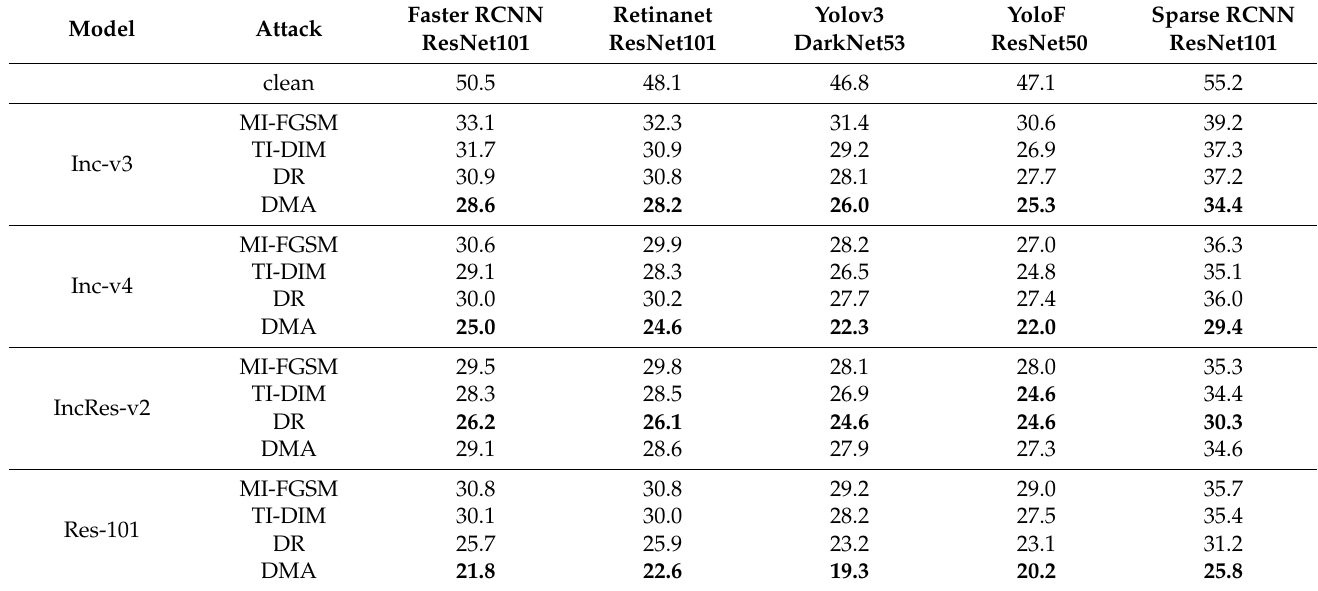
Table 4. The detect results (mAP) of the adversarial examples crafted by MI-FGSM, TI-DIM, DR, and DMA on Inc-v3, Inc-v4, IncRes-v2, and Res-101,